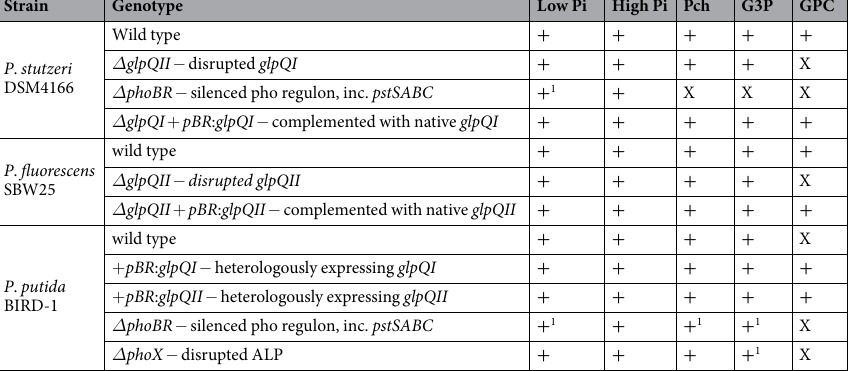
Table 1. Growth characteristics of the various strains and mutants used in this study with respect to P utilisation. Abbreviations: Pi, orthophosphate; Pch, phosphorycholine; G3P, glycerol 3-phosphate;